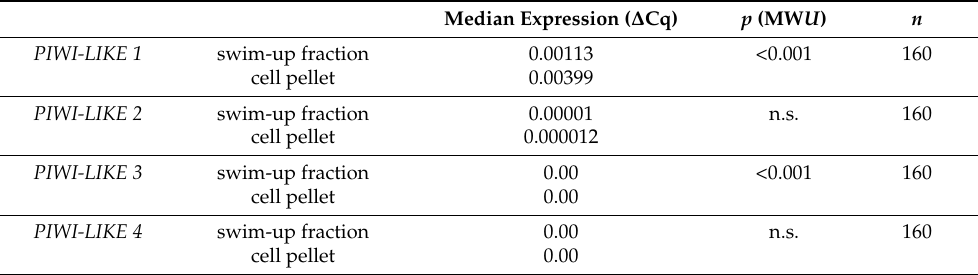
Table 1. Distribution of PIWI-LIKE gene transcripts in spermatozoa from the swim-up and the cell pellet fraction.